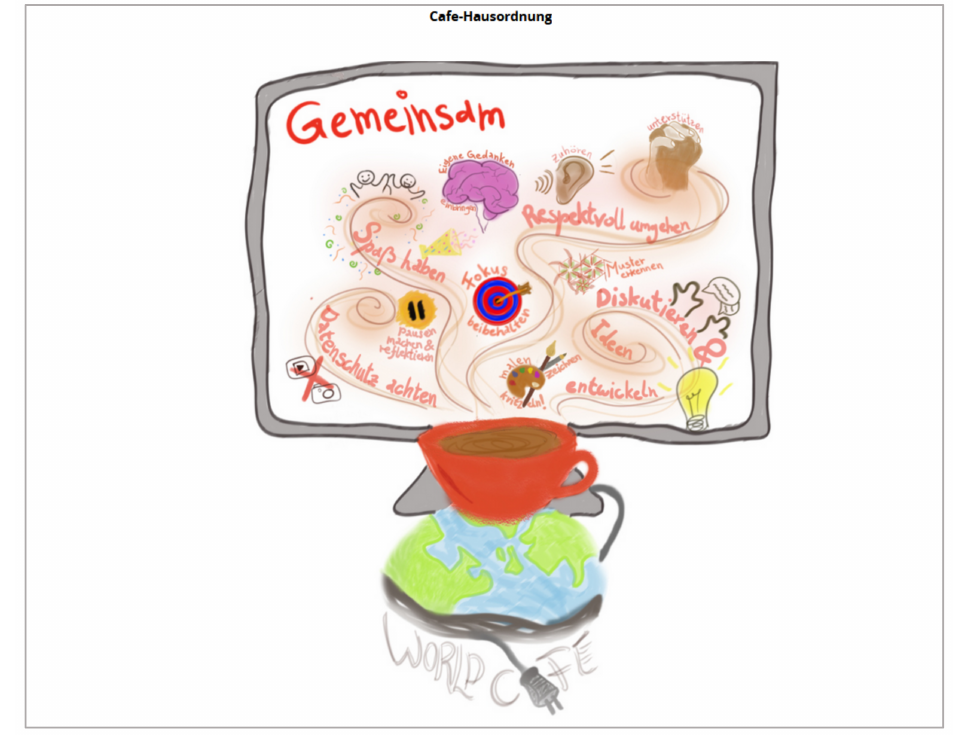
Figure 2. Conceptboard tile